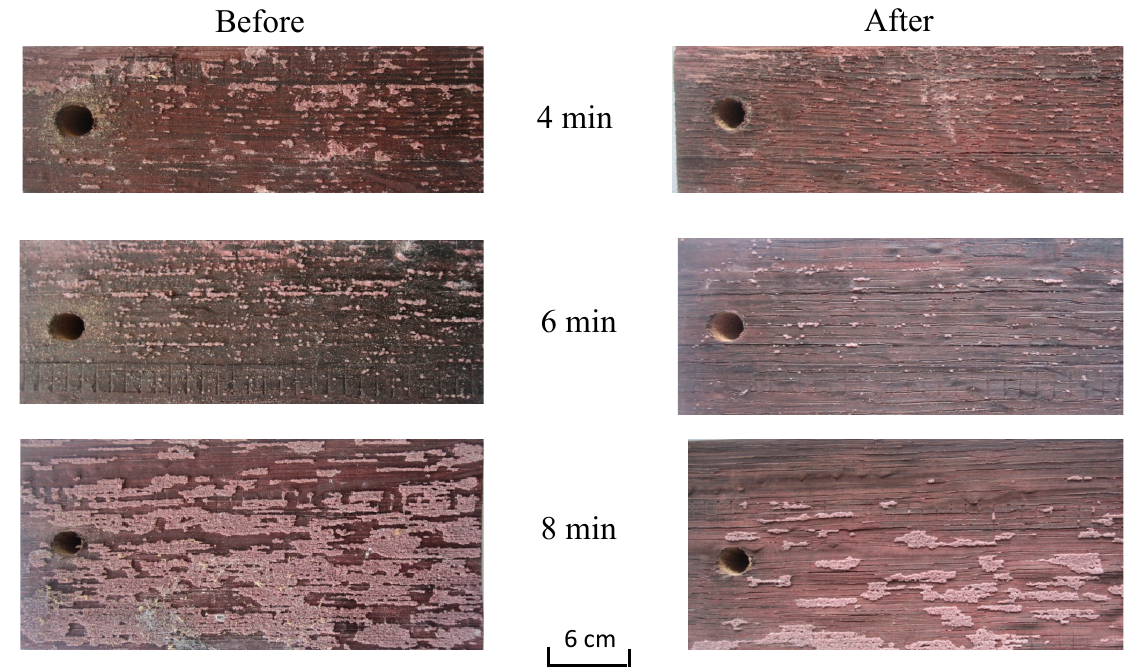
Figure 5. Examples of tartrate removal before and after HPU treatment (60 °C).